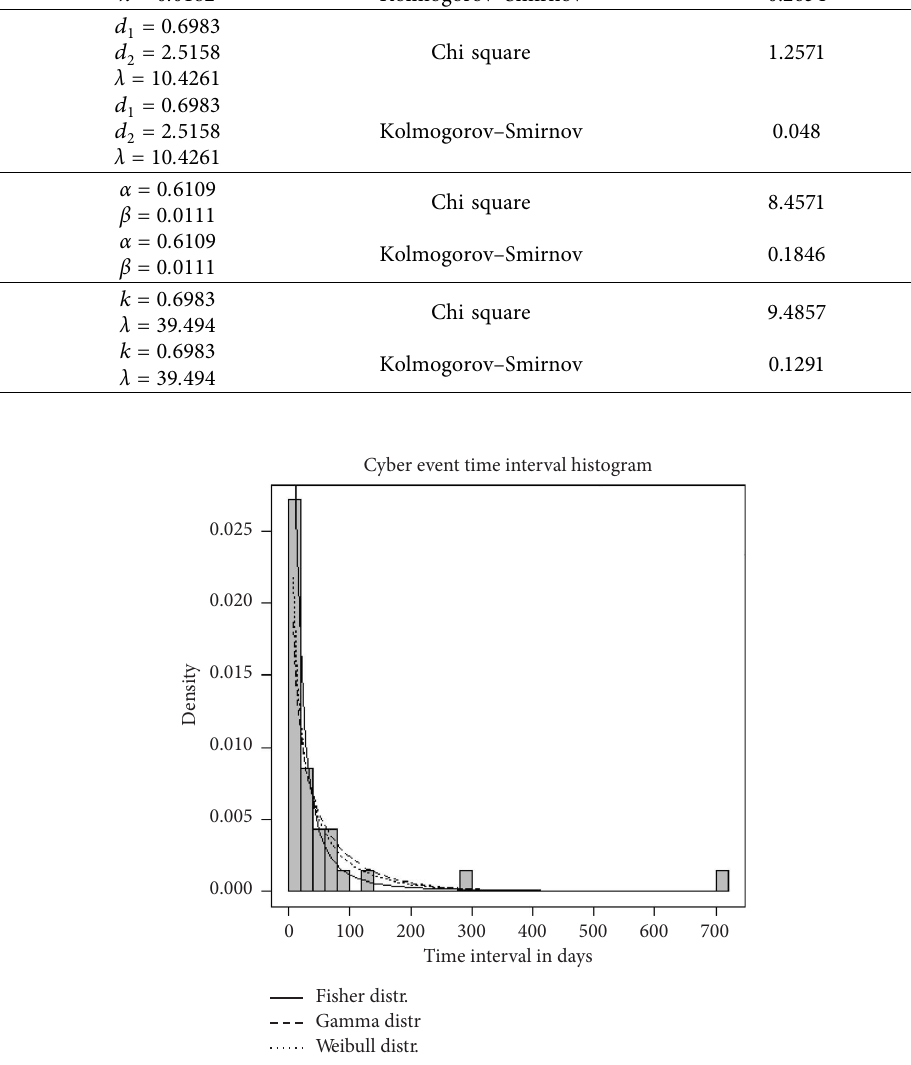
Figure 13: Cyber fraud loss frequency histogram and its assumed distributions. Table 15: Cyber-related fraud loss severity distribution parameters. Table 16: Cyber-related fraud loss severity distribution GOF